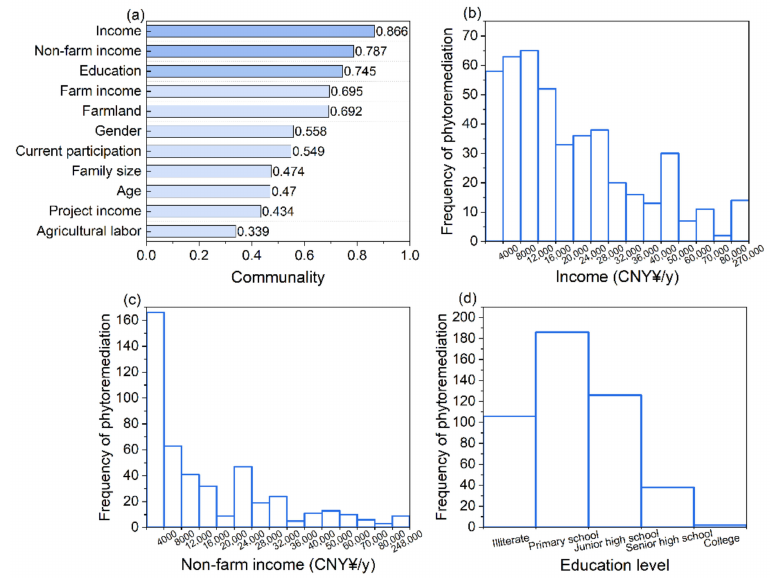
Figure 7. Characteristics of farmers intended for phytoremediation. ( a ) communality of characteristics of farmers intended for phytoremediation extracted by PCA. The dark blue, communality > 0.7. Frequency distribution of ( b ) income, ( c ) non-farm income, and ( d ) education level of farmers who chose